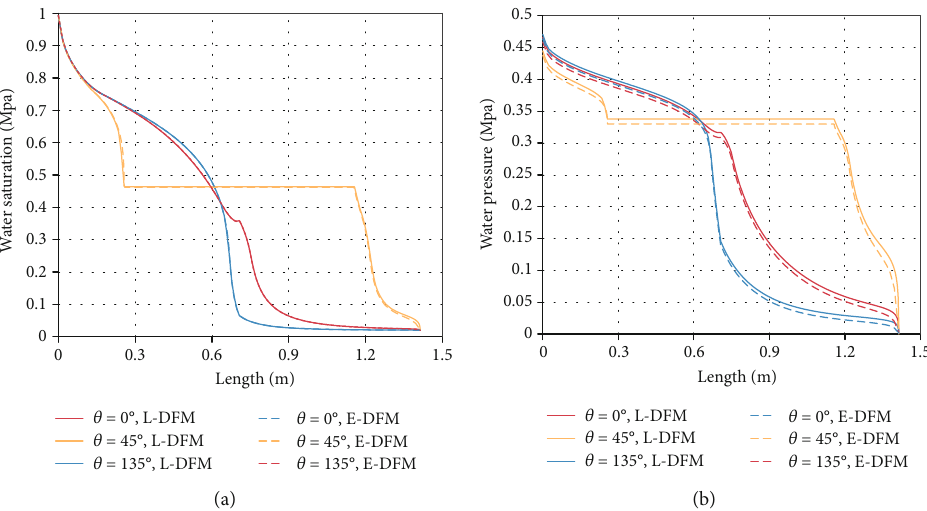
Figure 5: Comparisons of water saturation and pressure along the diagonal line from the injection well to the production well after 50 days of water injection with L-DFM and